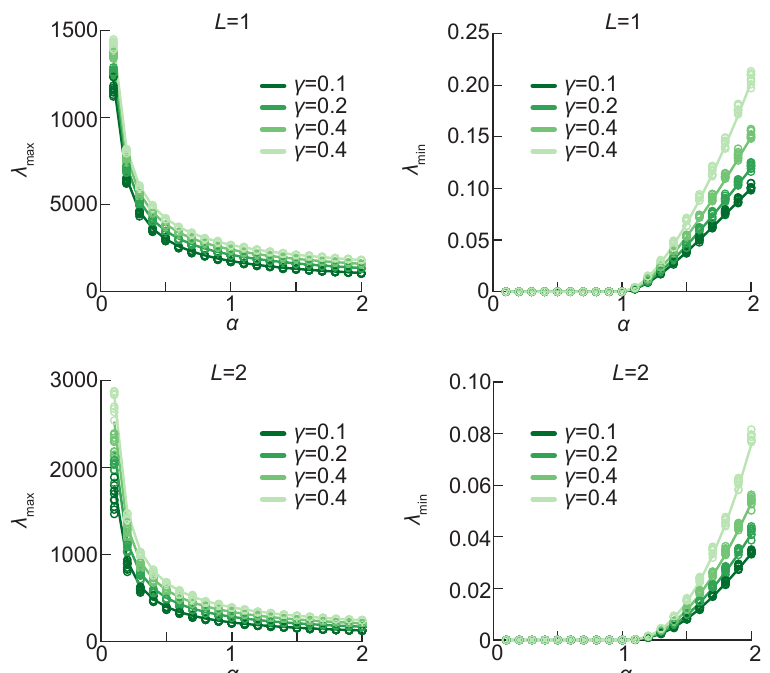
Figure 5: Maximum ( left ) and minimum ( right ) eigenvalues for structured Wishart product matrices for depths L = 1 ( top ) and L = 2 ( bottom ) of varying widths α = ··· = α = α . The correlation structure is as described in the main text, with L 1 ( z ) given by (37) with signal eigenvalues σ = 100 and varying signal fraction γ , M Σ 1 indicated by shades of green. Solid lines show the result of solving equation (60) nu- merically, while the open circles show the results of numerical eigendecompositions = for 10 realizations of matrices of size n 0